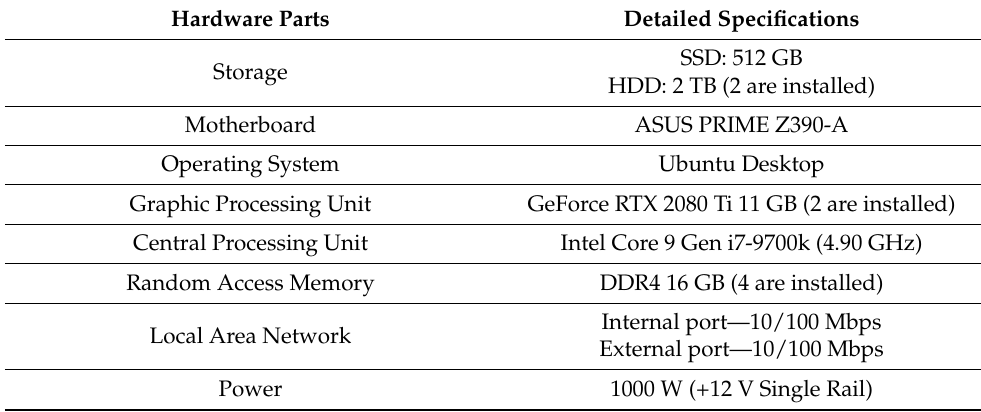
Table 4. The specifications of the AI server.